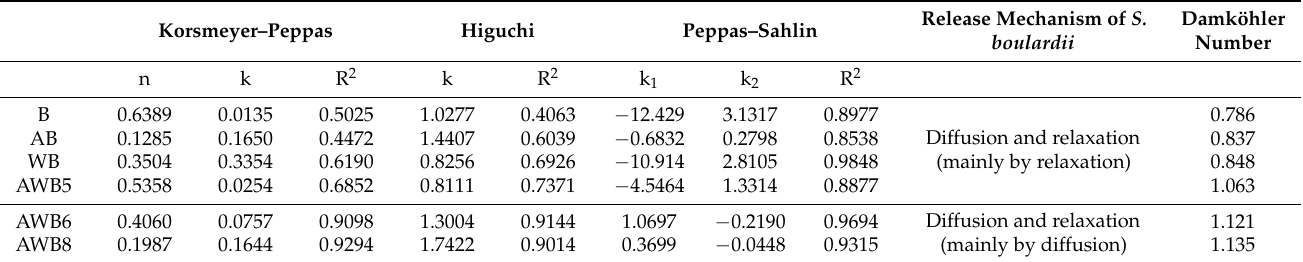
Table 2. Release mechanisms and Damköhler number of S. boulardii in different